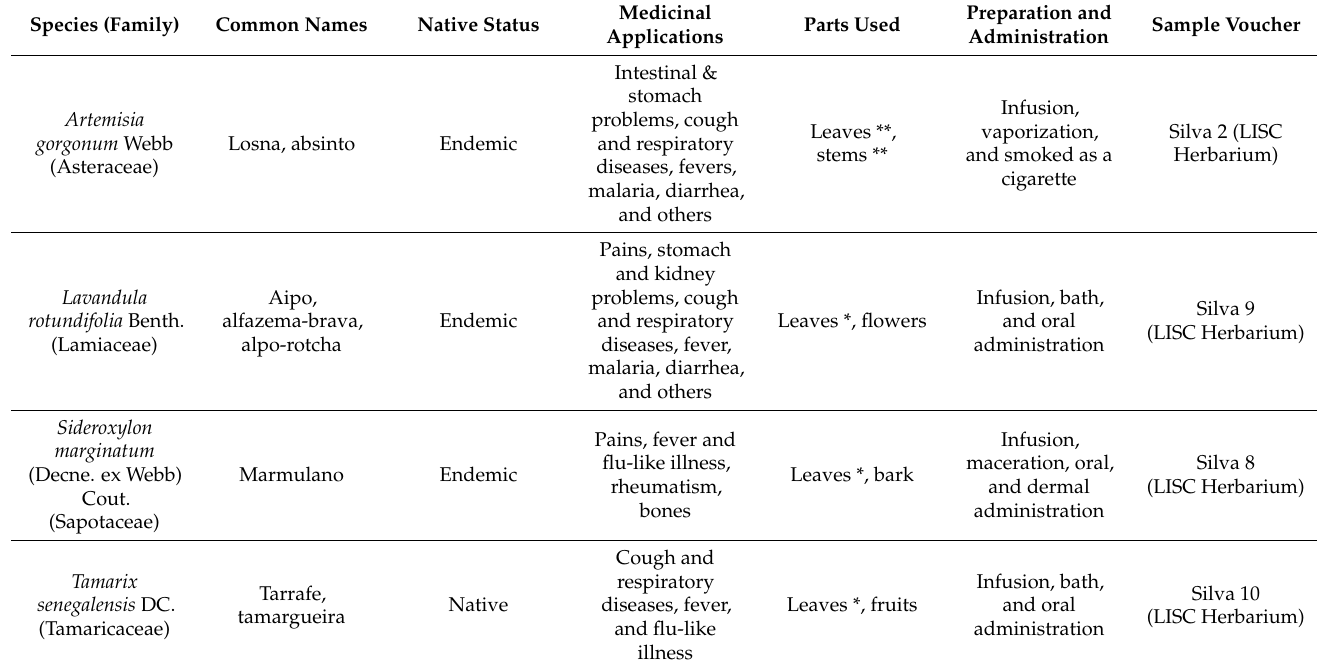
Table 4. Plant species studied and their respective traditional uses